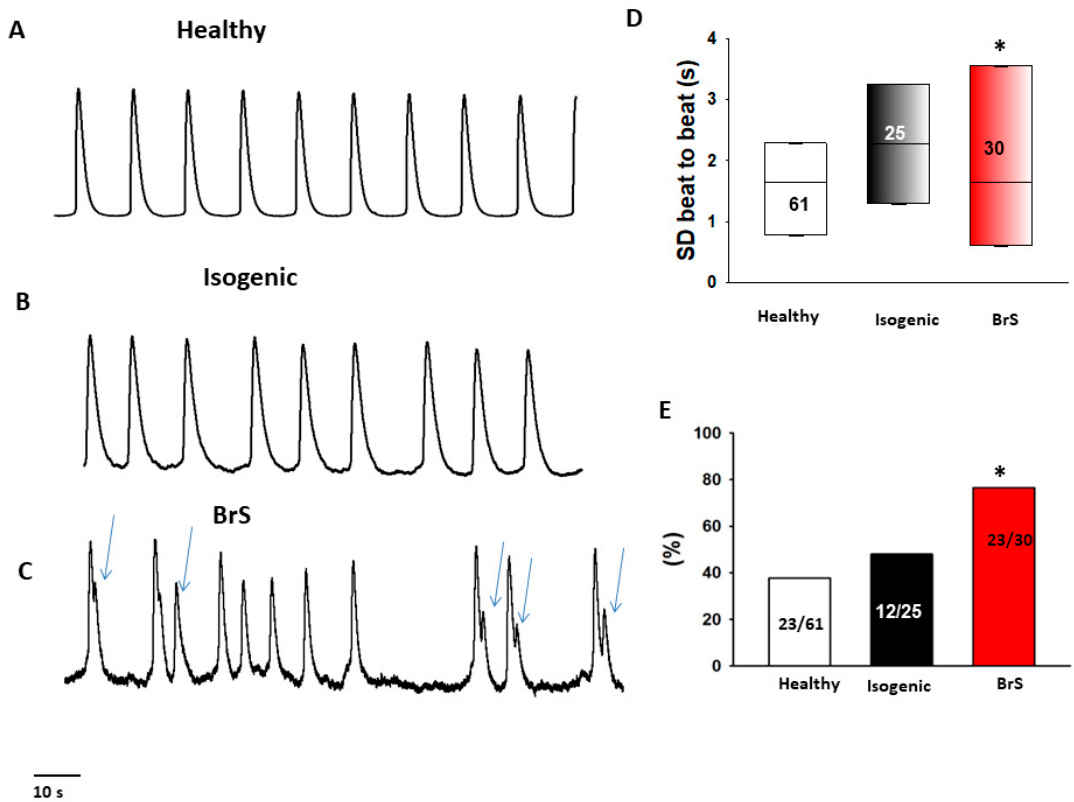
Figure 5. Increased beating variability and arrhythmic events in BrS-hiPSC-CMs. Spontaneous calcium transients were recorded in spontaneously beating hiPSC-CMs from the BrS patient, the healthy donor (healthy) and the CRISPR-corrected cells (isogenic). The beating variability (standard deviation (SD) of cell beating intervals) and the occurrence of arrhythmic events (irregular or triggered beats or EAD-like events) were compared among the three cell groups. ( A – C ) Representative traces of calcium transients in cells from each line. Arrhythmic events are marked by arrows. ( D ) Median values of standard deviation (SD) of cell beating intervals. ( E ) Percentage of cells showing arrhythmic events. The numbers given represent number of cells showing arrhythmic events versus total cell number. The numbers given represent number of cells. * p < 0.05 versus healthy according to the one-way ANOVA ( D ) or Fisher’s exact test ( E